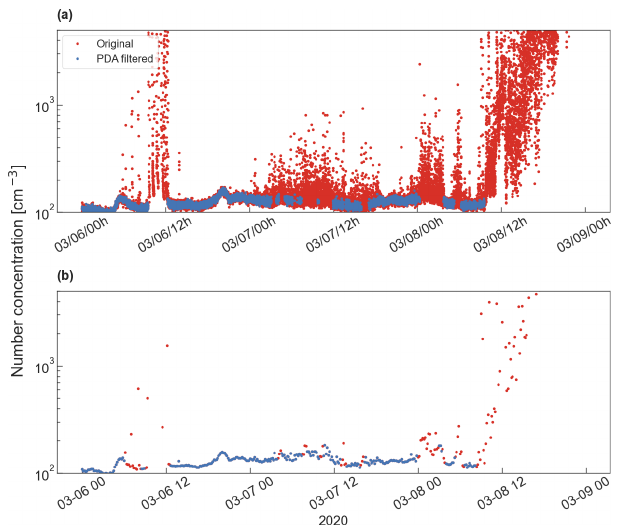
Figure C2. Performance test of the PDA on datasets with two differ- ent time resolutions: (a) 10s time resolution data; (b) 10min time resolution data. Filtered data in blue are shown on top of the original data of the corresponding time series in